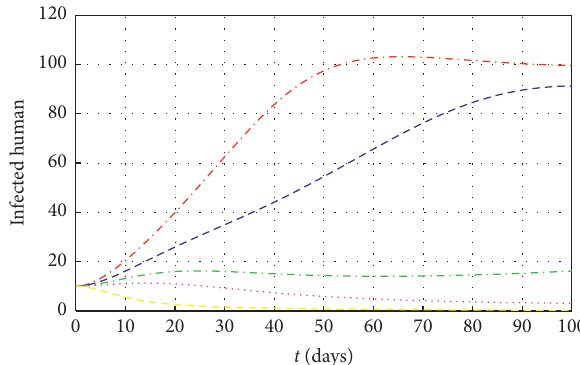
Figure 8: Population of unaware infected humans with different biting rates after awareness (without awareness (red line); with low to high awareness rate (blue, green, magenta, and yellow line)).